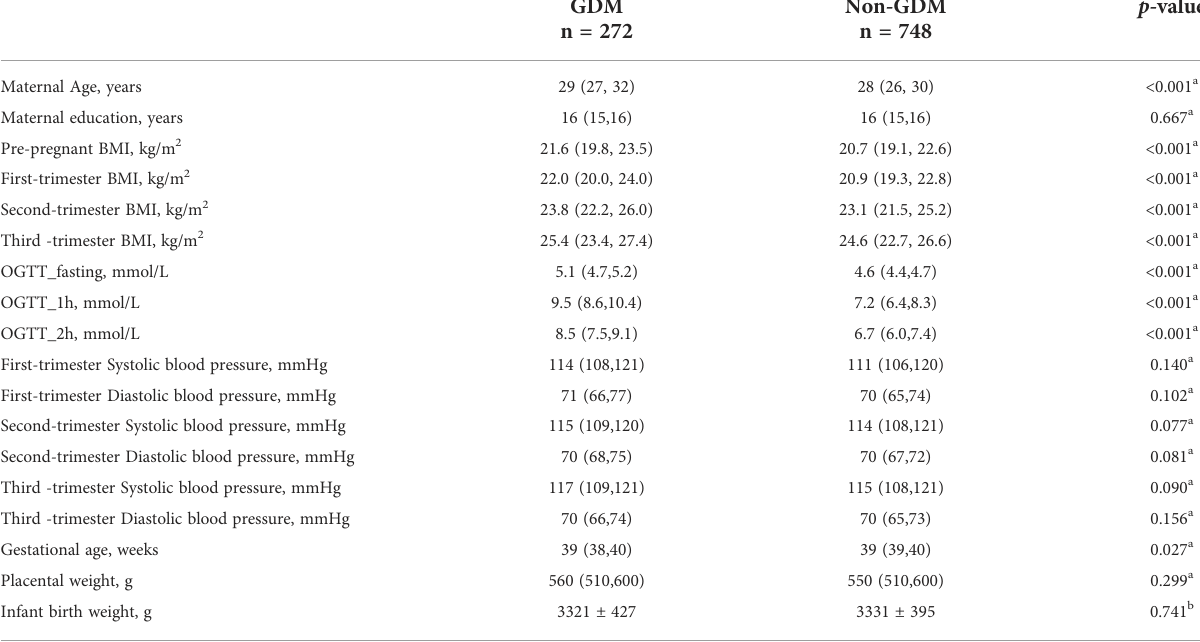
TABLE 1 Clinical characteristics of the study